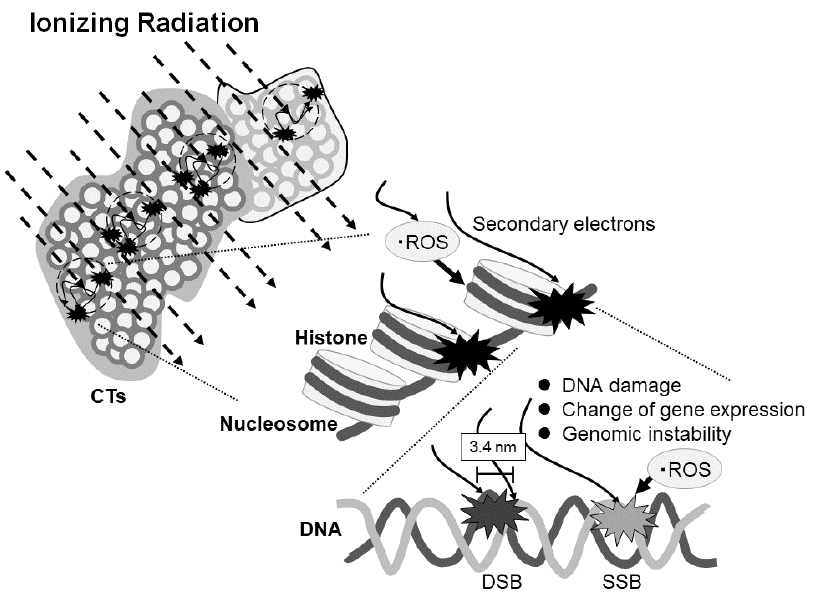
Figure 4. Scheme of the effect of ionizing radiation on DNA damage and gene expression depending on the region of the chromosome territories (CTs). Ionizing radiation stochastically enters the CTs and generates secondary electrons which may cause the reactive oxygen species (ROS). The electrons and ROS can induce single- or double-strand breaks or affect gene expression or genomic stability. DSB and SSB represent double strand break and single strand break, respectively.